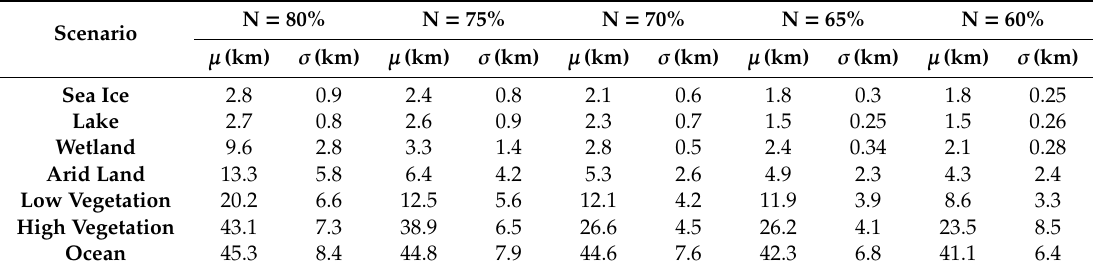
Table 1. Mean size of the scattering area (diameter) of GPS reflections over a variety of scenes and N values as measured by